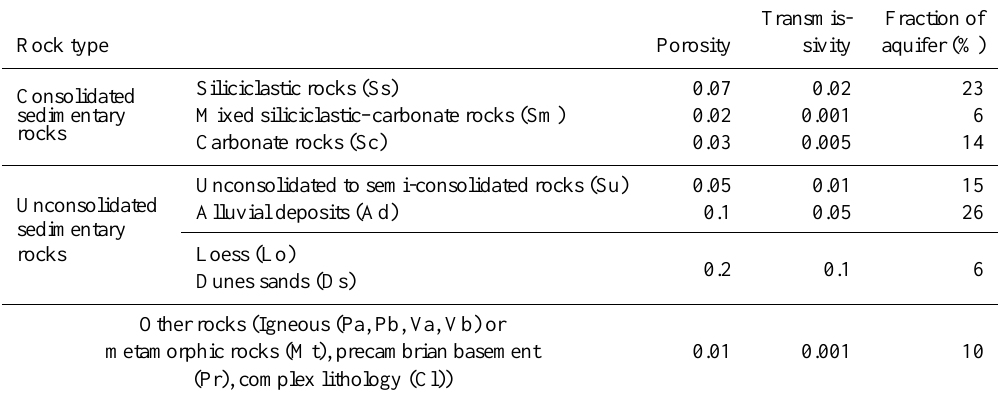
Transmis- Fraction of